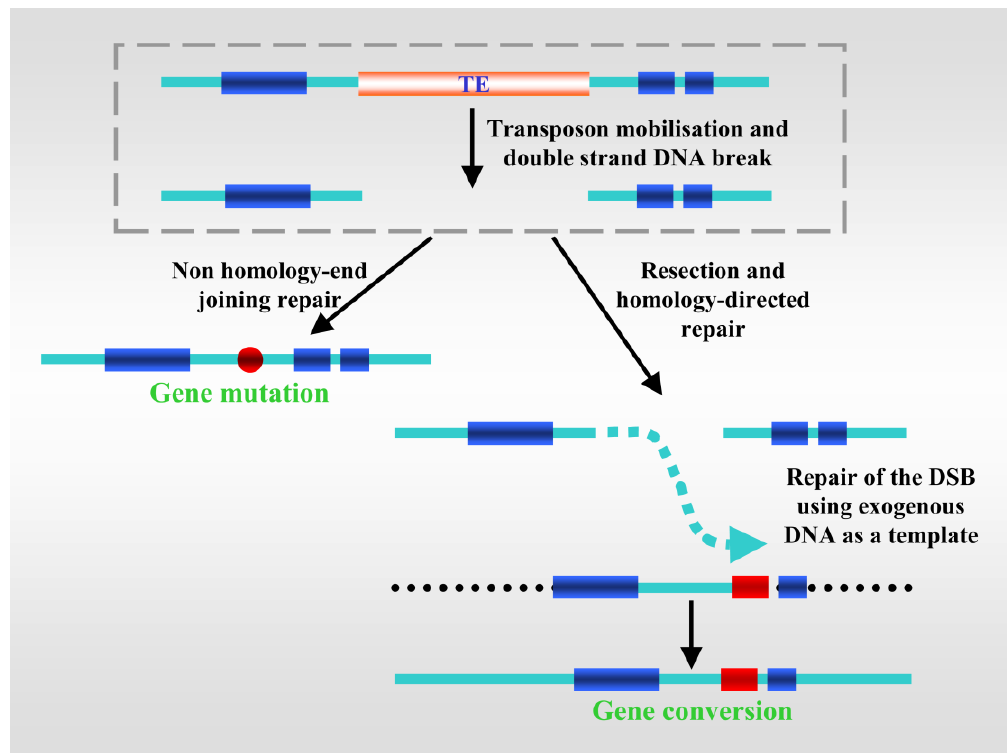
FIGURE 1. Mutagenesis and gene conversion driven by transposable element mobilisation. After mobilisation of a transposable element, a DSB is created. The presence of the DSB activates the endogenous repair machinery in the cell. The lesion may then be removed by direct end-joining repair (left arrow). This type of repair may result in the introduction of small insertions or deletions (represented in the diagram by a red dot). If, in contrast, the free DNA ends are resected, the resulting gap may then be repaired using a homologous strand of DNA (right arrow). The homologous template may be a homologous chromosome resulting in gene repair or an exogenous sequence, with partial homology to the damaged chromatid, which will result in gene conversion (represented in the diagram by a red bar). Double DNA strands are shown in blue. Exogenous DNA is shown by a dotted black